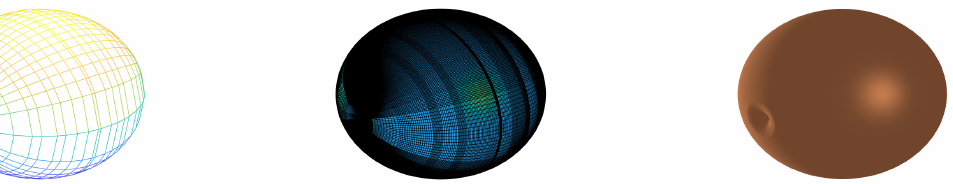
Figure 17. Subdivision surface of space with NULTISS. Left to right: initial mesh; mesh after three refinements; surface with lighting after three refinements.